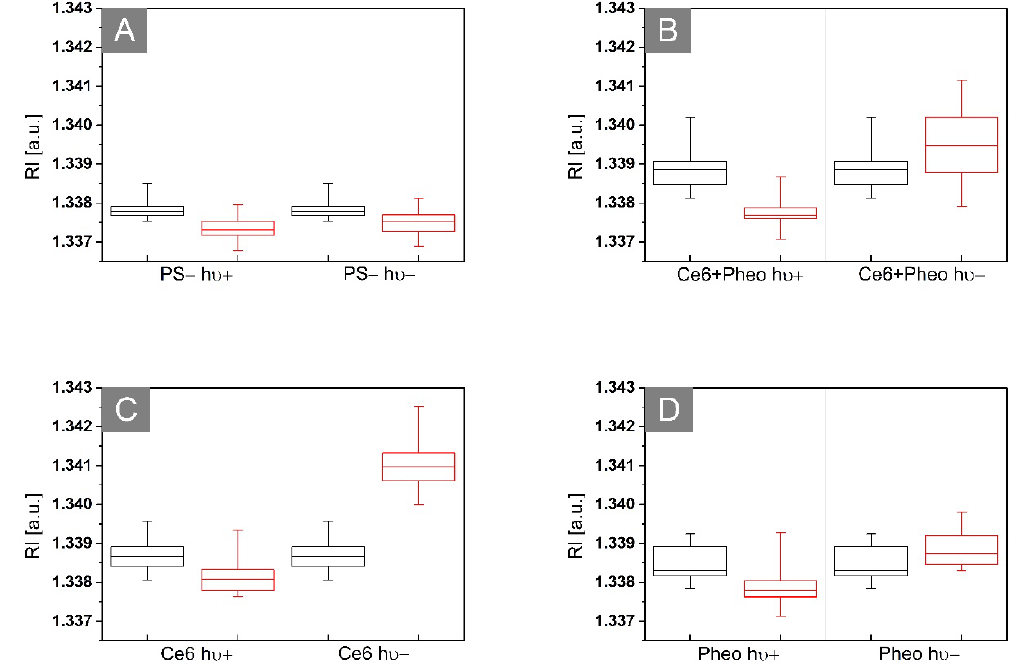
Figure 5. Representative box plots of 3D-RI values of E. coli cells 24 h (black boxes) and 48 h (red boxes) after incubation without PS ( A ) or with Ce6 + Pheo ( B ), Ce6 ( C ), and Pheo ( D ) (h ν +: irradiated, h ν − : non irradiated).